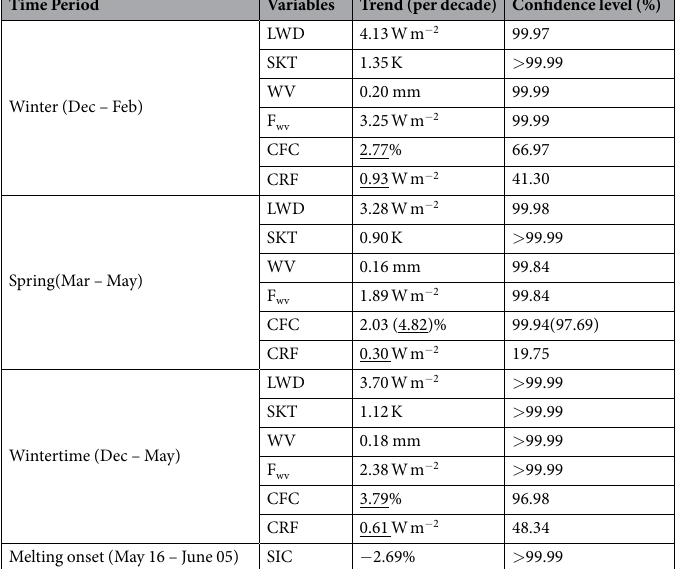
Table 1. Statistical linear trends of surface downward longwave radiation (LWD), skin temperature (SKT), precipitable water vapor (WV), WV radiative forcing (F wv ), cloud fraction (CFC), cloud radiative forcing (CRF) and onset SIC from 1985 to 2014. Values marked with underline are the linear trends from 2001 to 2014. Confidence level is the complement of the significance (here, p-value based on F-test) of a linear trend, calculated as “(1 - significance) ×